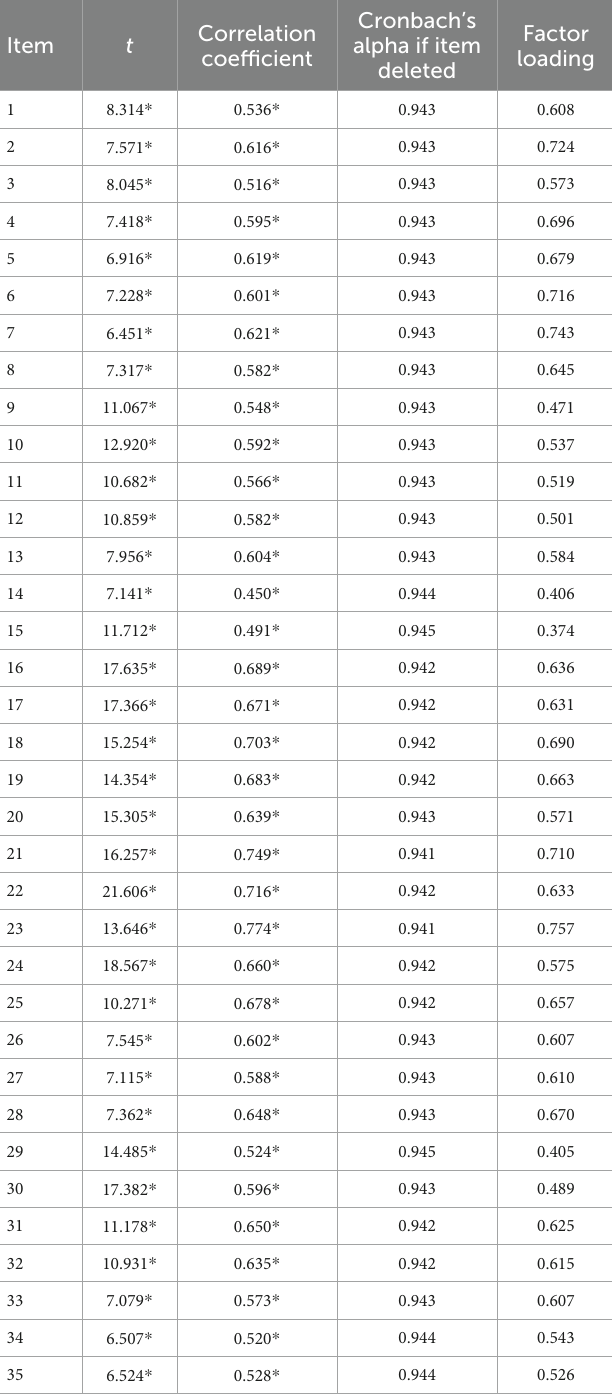
TABLE 2 Statistic results of item analysis ( n =